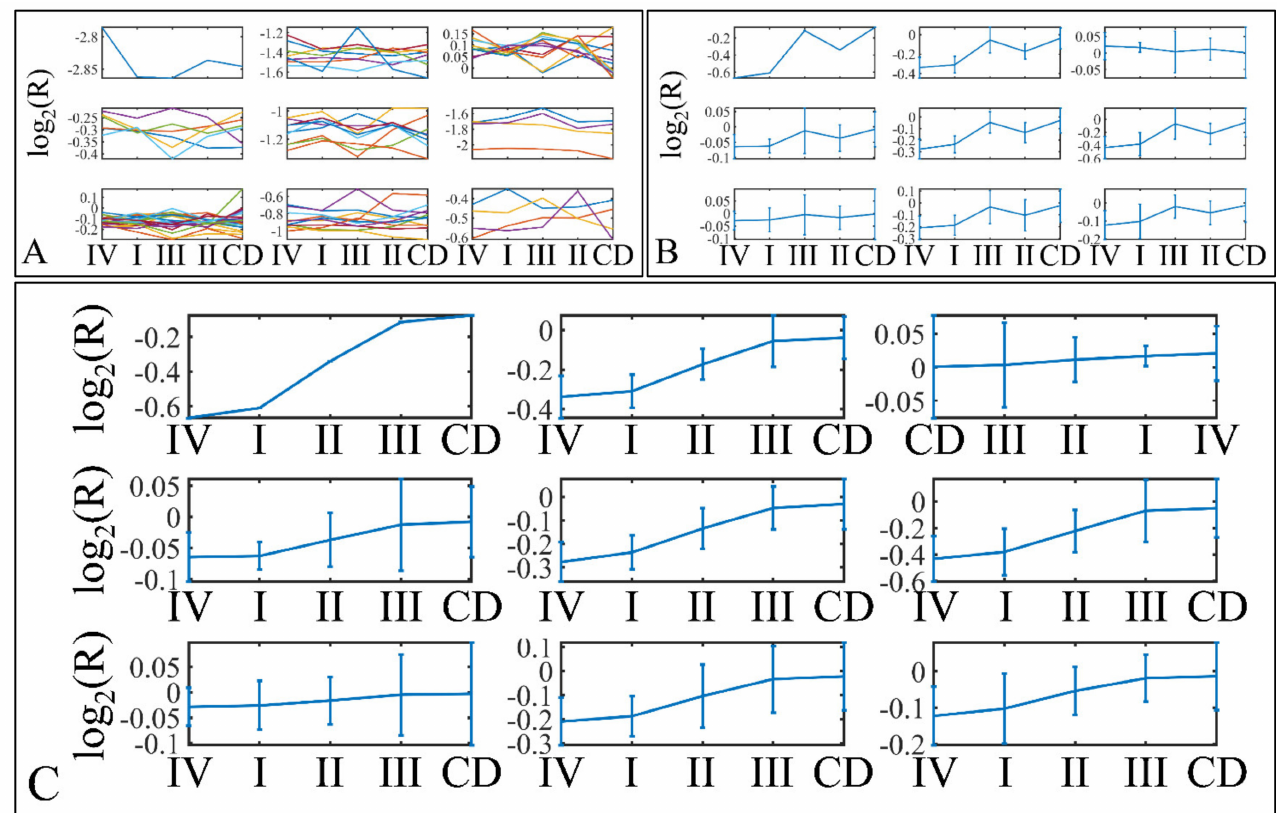
Figure 13. Descriptive k-means of tumor staging (tumor grade). Tumor samples were clustered with respect to the clinical (categorical variables) parameters of tumor grade ( A , B ). The first representation concerns the k-means classification of the miRNA expression data ( A ), whereas it is followed by the k-means centroids ( B ). The centroids in ( B ) represent the mean values of the k-means clusters depicted in ( A ). Those centroids (depicted in ( B )) were sorted in an ascending order, in an attempt to find patterns related to tumor staging ( C ). Indeed, an interesting pattern was revealed with respect to tumor grade, where k-mean sorted centroids ( C ), showed a descending pattern from grade I to III, as well as an ascending pattern from grade III to I ( C ) (Legend: I: grade I ( n = 16); II: grade II ( n = 9); III: grade III ( n = 3); IV: grade IV ( n = 18); CD: Cortical dysplasia ( n =